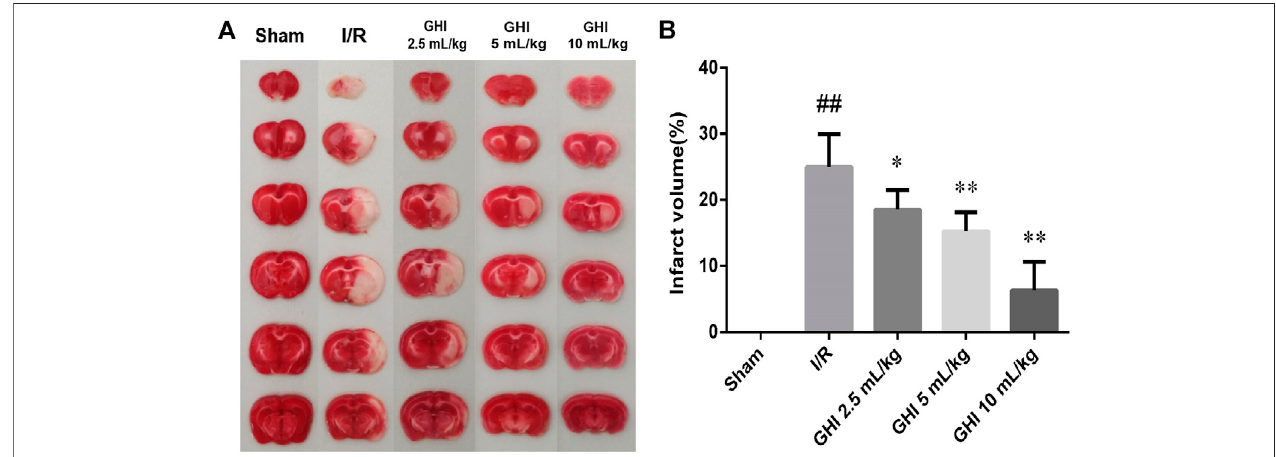
FIGURE 2 | Effect of GHI on cerebral infarct volume in the focal cerebral I/R rats. Infarct volume was assessed by TTC staining at day 7 after tMCAO. (A) Representative TTC staining of the cerebral infarct of rat brain. (B) Infarct volumes assessed by TTC staining. Groups were as follows: Sham group (Sham), ischemia-